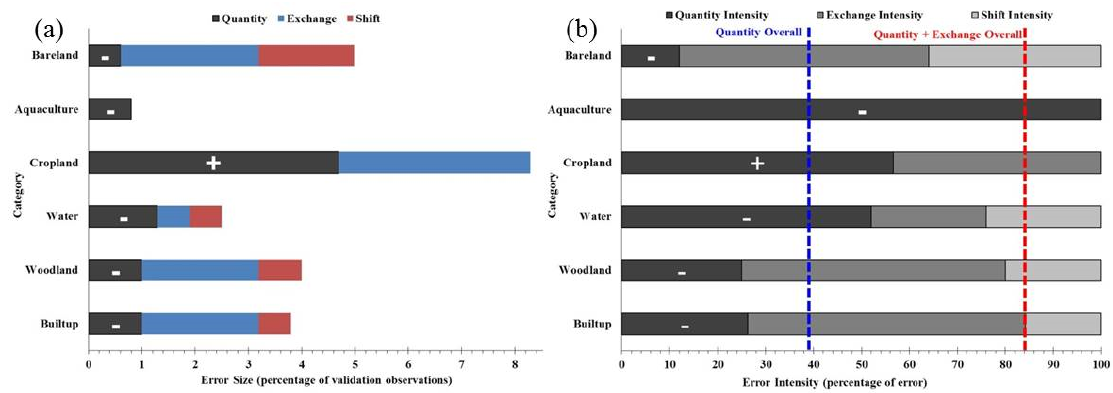
Figure 6. Category level components of error at 2016 in terms of ( a ) size and ( b ) intensity. The + symbol denotes that the map overestimates the size of the category while the—symbol denotes that the map underestimates the size of the category. Dashed lines show the overall component intensities in